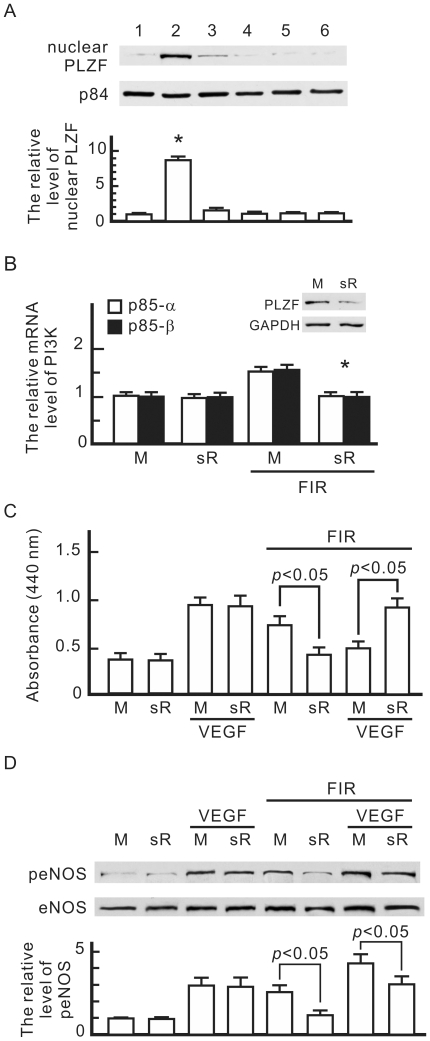
Involvement of the promyelocytic leukaemia zinc finger (PLZF) in the biological effect of FIR.(A) Western blotting of nuclear PLZF in HUVECs. HUVECs were treated as below: 1, none; 2, FIR exposure for 30 min; 3, FIR exposure for 30 min and then culture for 30 min; 4, VEGF (10 ng/ml) treatment alone for 30 min; 5, 38°C culture alone for 30 min; 6, 39°C culture alone for 30 min. Nuclear proteins were extracted and detected with a PLZF monoclonal antibody. Nuclear matrix protein p84 was detected as a loading control. By comparison with the control without FIR exposure, relative levels of nuclear PLZF were obtained and are shown as the mean±S.D. from six determinations in three cell preparations. * p<0.05 vs. the control without FIR exposure. (B) PLZF siRNA transfection-influenced RNA levels of PI3K p85. HUVECs were transfected with PLZF siRNA (sR) or mock control RNA (M). PLZF expression was monitored by a western blot analysis. Transfected cells were treated with or without FIR exposure as indicated for 30 min. The mRNA quantity of PI3K in each sample was detected by a qPCR with specific primers for PI3K subunits p85α and p85β. The relative mRNA level of FIR-induced PI3K is shown as the mean±S.D. from six experiments. * p<0.05 vs. the mock control with FIR exposure. (C) PLZF siRNA transfection-influenced cell proliferation in HUVECs. Transfected cells were pretreated with VEGF (10 ng/ml) or FIR exposure as indicated for 30 min, and then cultured overnight. Data are shown as the mean±S.D. from six experiments. (D) PLZF siRNA transfection-influenced phospho-eNOS in HUVECs. Transfected cells were treated as indicated and then cultured for 1 h. We detected eNOS as a loading control, and quantified phospho-eNOS expression relative to eNOS. By comparison with the mock control without VEGF treatment and FIR exposure, relative levels of phospho-eNOS were obtained and are shown as the mean±S.D. from six determinations in three cell preparations.